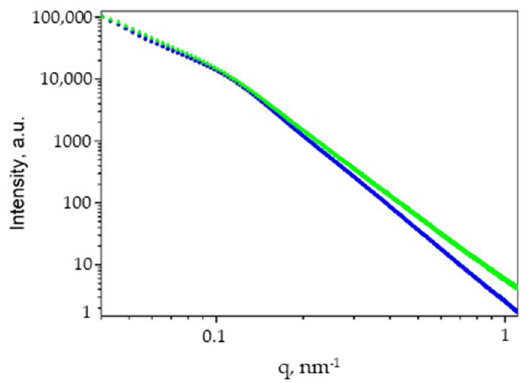
Figure 11. Small-angle X-ray scattering patterns in double logarithmic scale for Ag-MCC (blue triangles) and Ag-AC (green triangles). Table 4. Morphological parameters of Ag-cellulose composites from SAXS